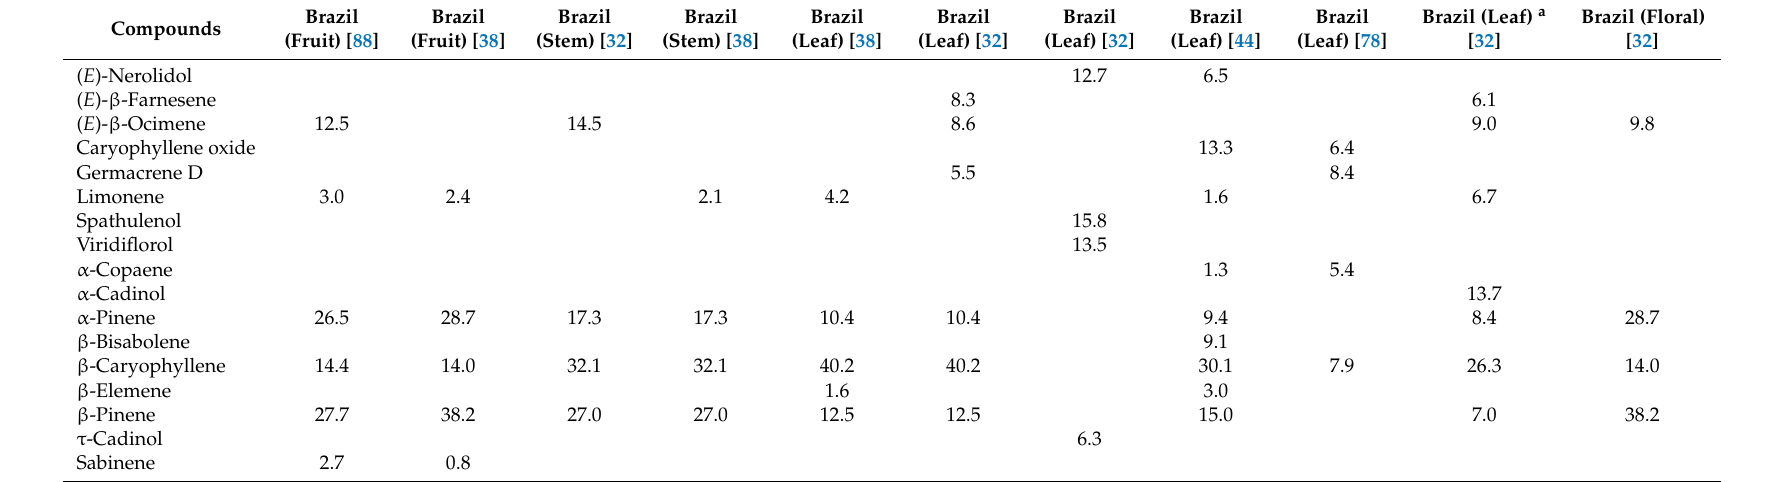
Table 21. Chemical compositions (%) of Piper tuberculatum Jacq. essential